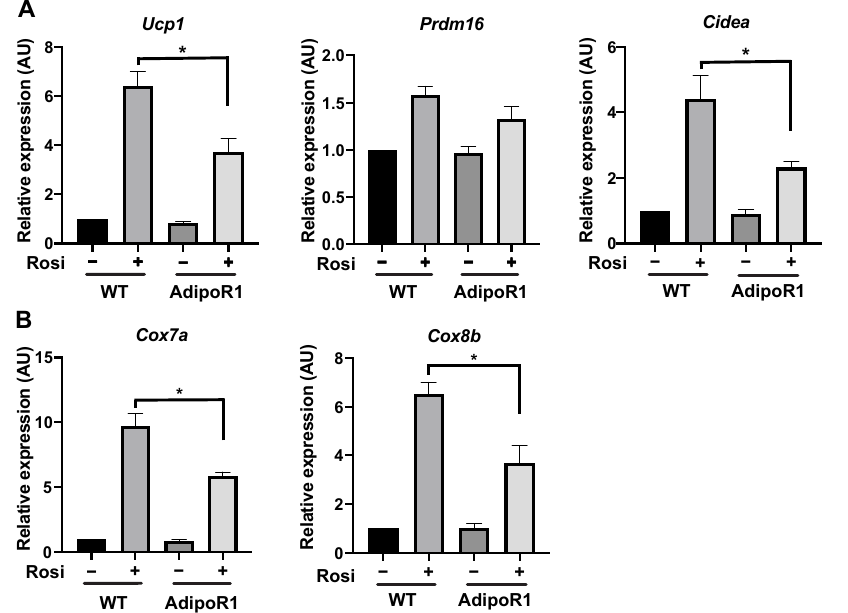
Figure 10. Decreased BAT thermogenic and mitochondrial markers in differentiated beige adipocytes from iWAT of AdipoR1 mice. Expression of ( A ) brown adipocyte markers and ( B ) BAT-enriched mitochondrial markers was evaluated by qPCR. Pre-adipocytes in the stromal/vascular fraction of subcutaneous iWAT (the potential depot for WAT browning or beiging) were derived from WT or transgenic AdipoR1 mice ( n = 3) and differentiated into mature beige adipocytes with or without a synergistic browning agent of PPARγ, rosiglitazone (Rosi). Data were presented as relative means (normalized to β-actin in arbitrary units, AU) ± SEM. * p ≤ 0.05.